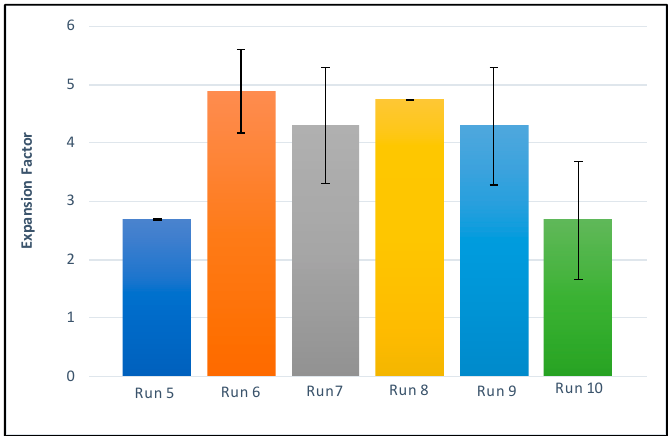
Figure 6. Expansion factor of the scaffolds.